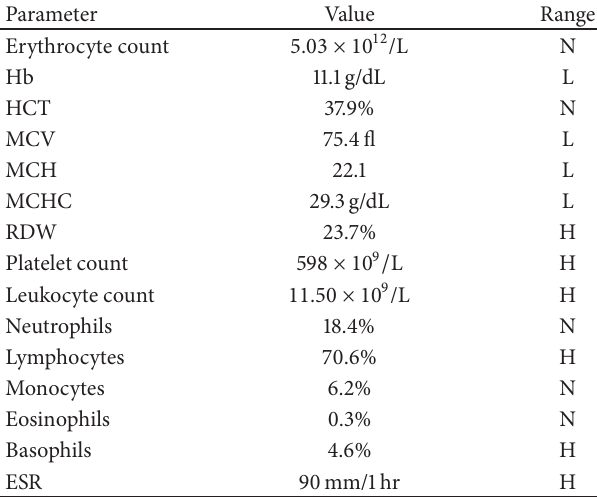
Table 1: FBP results. N: normal, L: low, H: high, Hb: haemoglobin, HCT: hematocrit, MCV: Mean Corpuscular Volume, MCH: Mean Corpuscular Haemoglobin, MCHC: Mean Corpuscular Haemoglobin Concentration, RDW: Red (Blood Cell) Distribution Width, and ESR: Erythrocyte Sedimentation